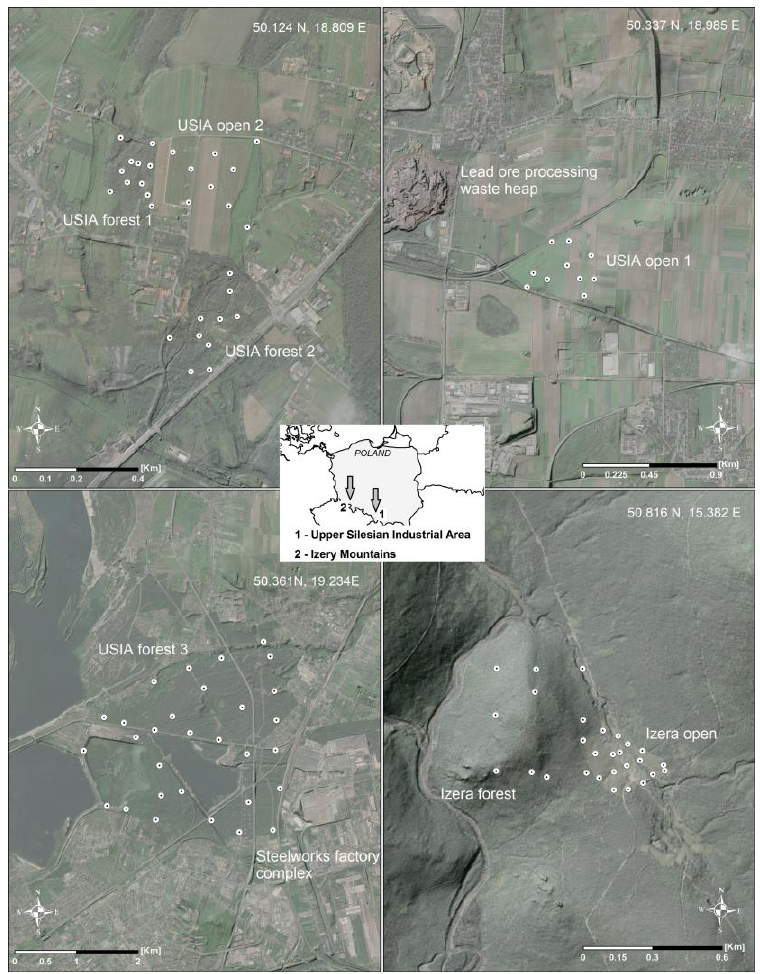
Figure 1. Location of study areas; locations of soil cores collection were marked with white circles; base maps: LIDAR (Light Detection and Ranging) map and orthophoto map (Esri). Study areas USIA open 2, USIA forest 1 and USIA forest 2 included one arable field and two adjacent forest areas, respectively (Figure 1). They were located (WGS84: 50.124˚ N, 18.809˚ E) in southern Poland, about 16 km south of the large Katowice agglomeration. The closest industrial emission source was the Laziska power plant, located about 2 km to the north-east of the study areas. The area USIA open 2 was an arable field, and the study area USIA forest 1 was located in a natural forest that was surrounded by arable fields. The dominant tree species were old black alder and young maple, oak and ash. The third study area, USIA forest 2, was located in a park, where the oldest trees were about 150 years old. Some parts of this park were overgrown with only weeds and shrubs. The geological bedrock of study areas USIA open 2, USIA forest 1 and USIA forest 2 were glacial sands and gravels (Quaternary). Dominant types of soils were brown leached and rainfall-glial soils developed of clay sands, loams, silt deposits and